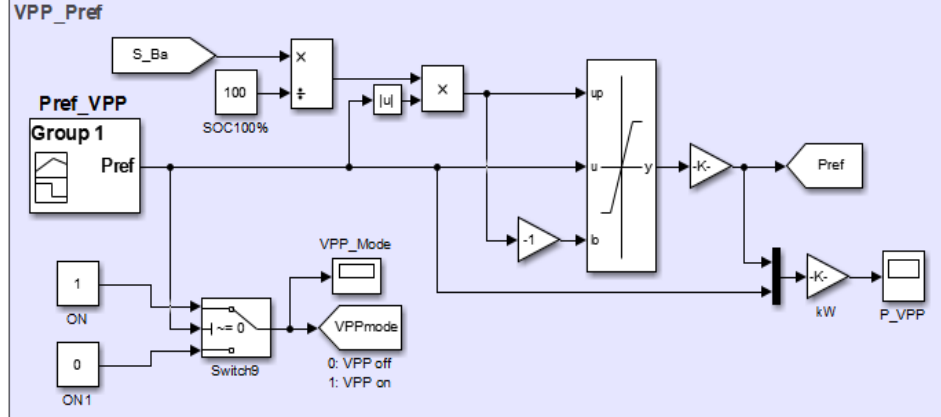
Figure A6. Block diagram of the VPP simulator.